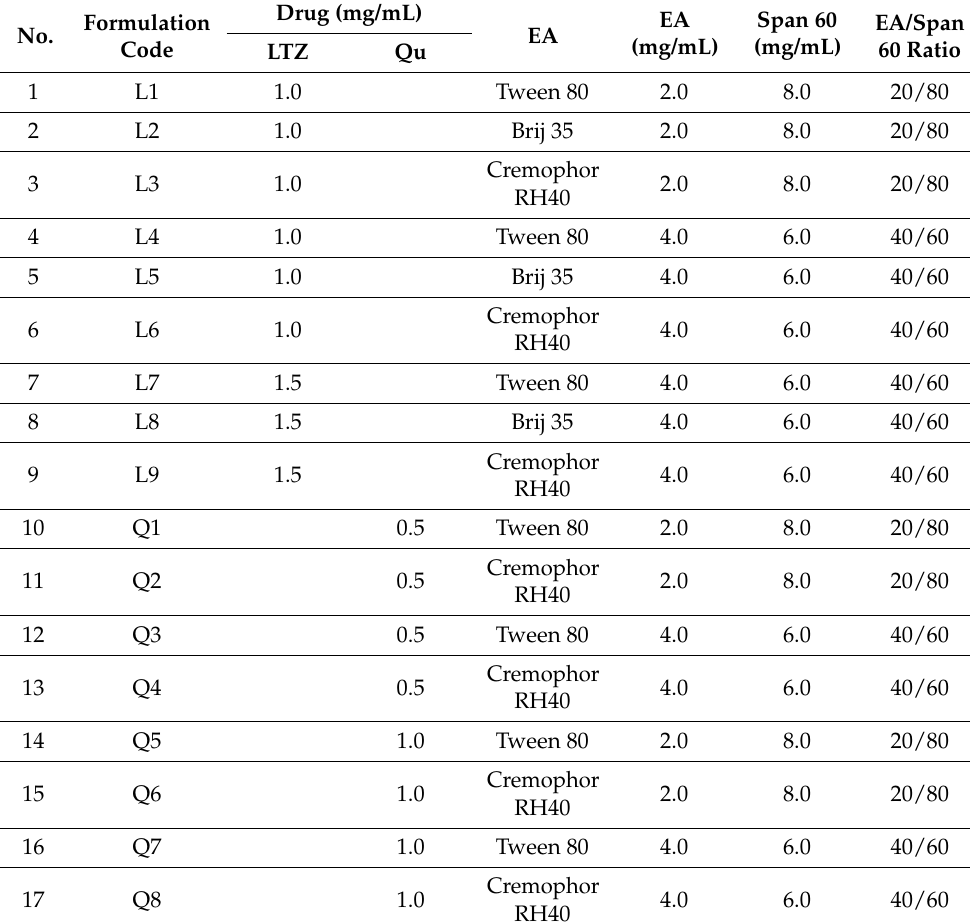
Table 1. Compositions of the prepared LTZSPs and QuSPs.